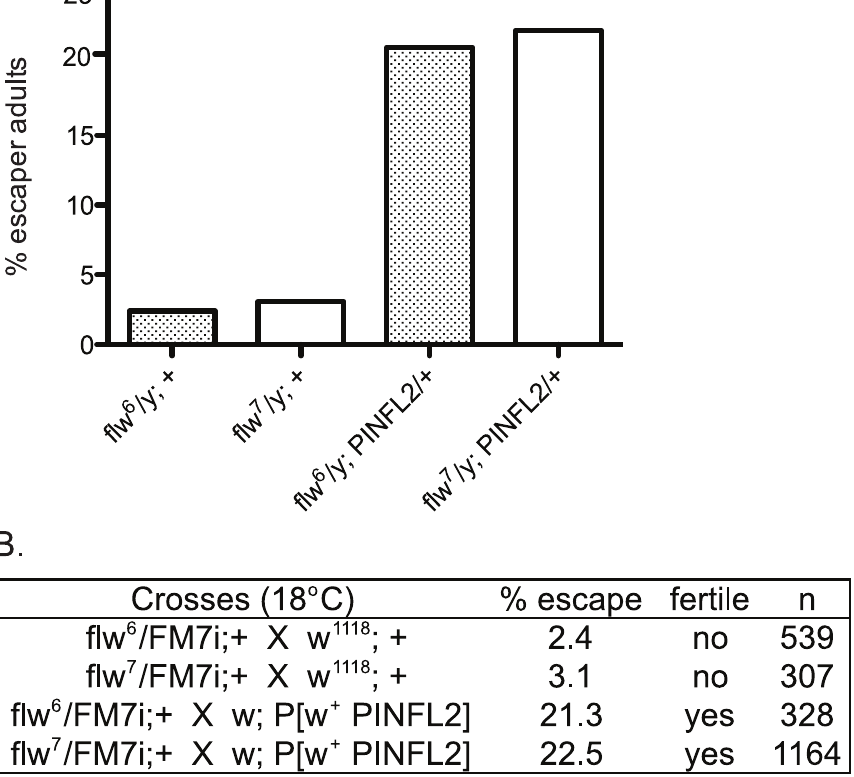
Figure 1. Expression of transgenic PINCH increases the number of flw adult male escapers and restores their fertility. A.) Bars show the frequency of escapers of the indicated genotypes. B.) The genetic crosses employed are shown, as well as the fertility status of the escapers. n is the total number of progeny of all genotypes resulting from the cross.